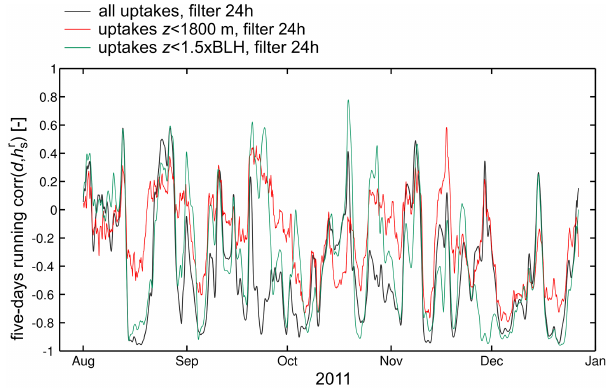
Fig. A2. Sensitivity of the 5-day moving window correlation be- tween d and h r s to the uptake height threshold. A comparison is shown of the correlation pattern with a fixed uptake threshold al- titude of 1800m (green curve), with an uptake threshold altitude of 1.5 times the boundary layer height (red curve) and without an uptake height threshold (grey